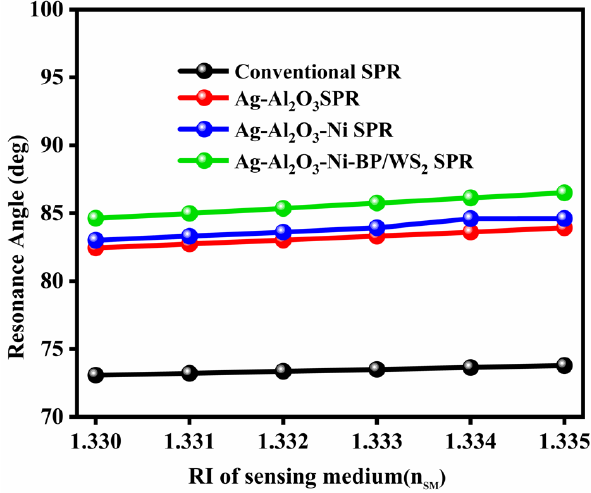
Figure 7. Variation of the resonance angle with Ri for different sensor